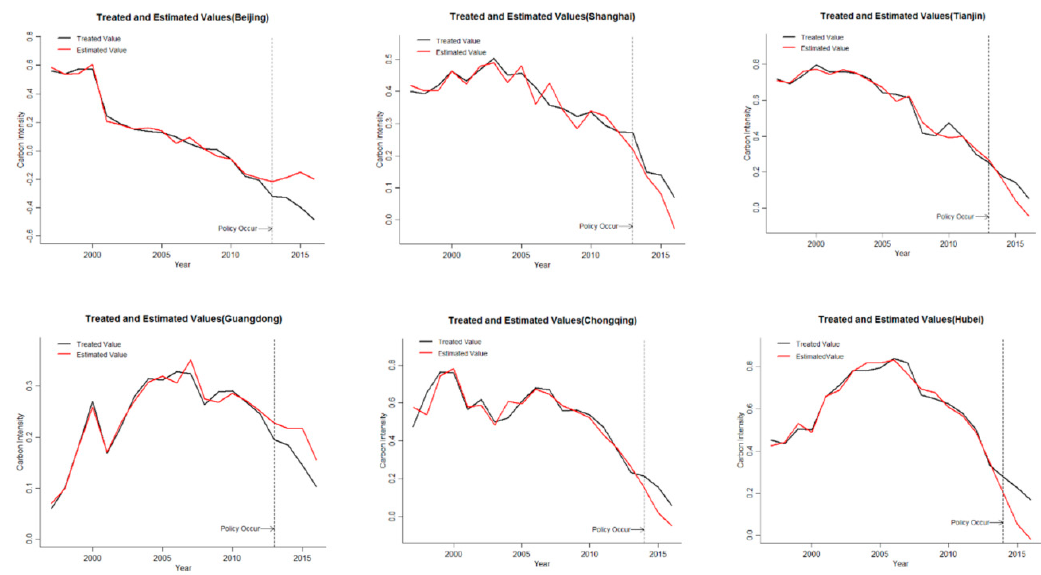
Figure 3. The treated value and the estimated value of the pilots.